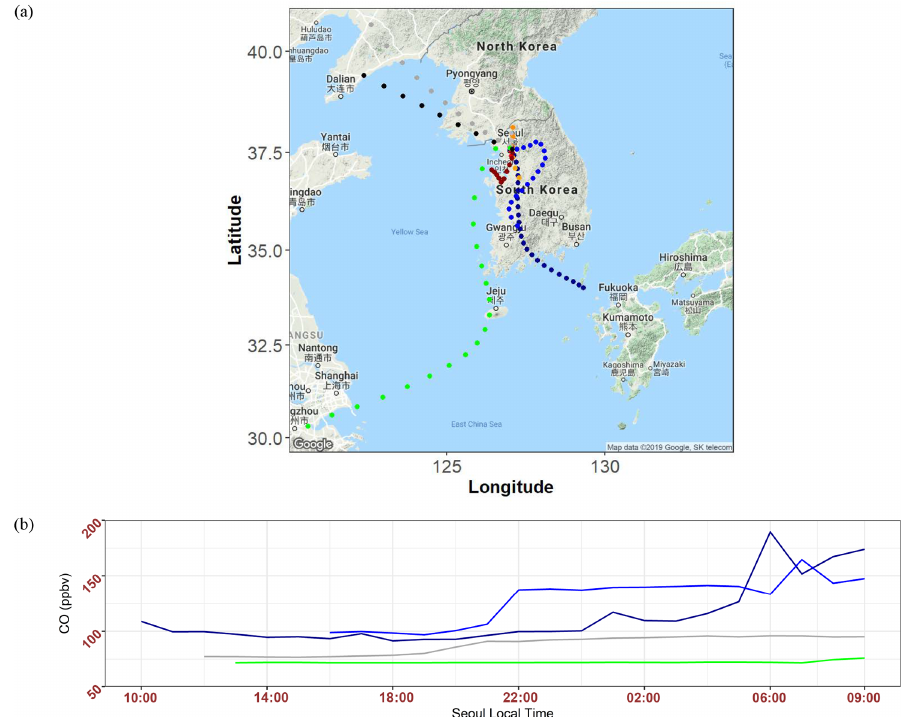
Figure 6. C-TRAIL output for 4 June 2016: (a) the trajectory of packets reaching Seoul at 09:00 local time (b) changes in the CO concen- trations of four aged packets moving toward Seoul from source